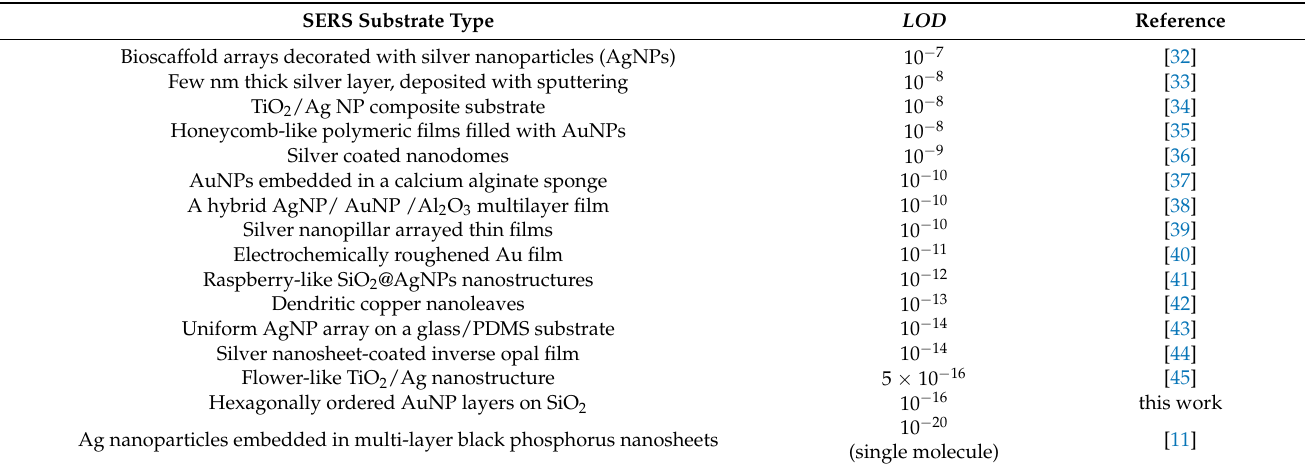
Table 2. Comparison of LOD of R6G detection for different SERS